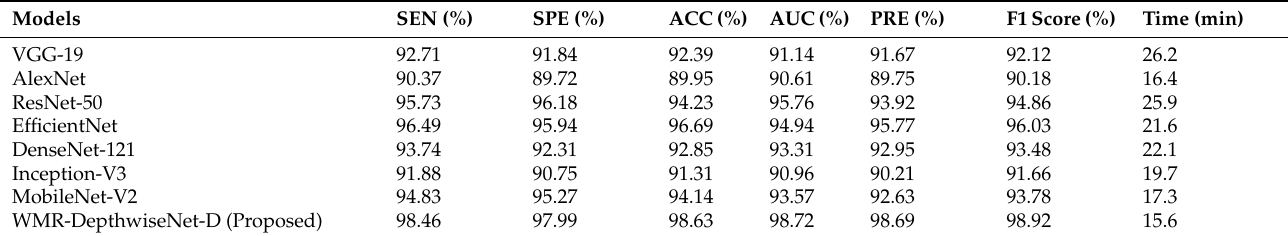
Table 6. Comparing the performance of our formulated WMR-DepthwiseNet with famous pretrained algorithms using the same CXR dataset. We only fine-tuned the last layer of the pretrained algorithms to match the number of classes.